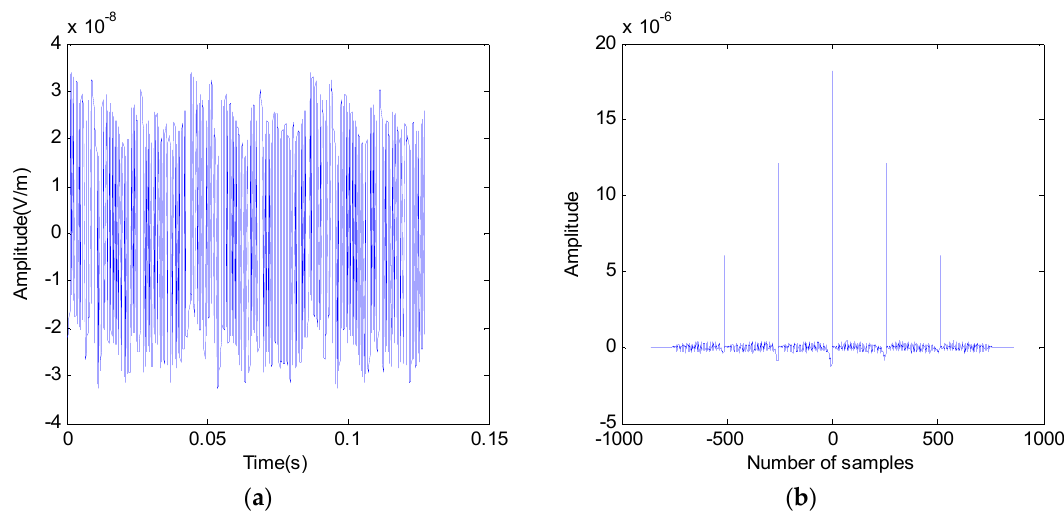
Figure 5. Calculation result of discrete cycle correlation method. ( a ) The field excited by pseudo-random sequences; ( b ) cross correlation of emission signals and response signals.